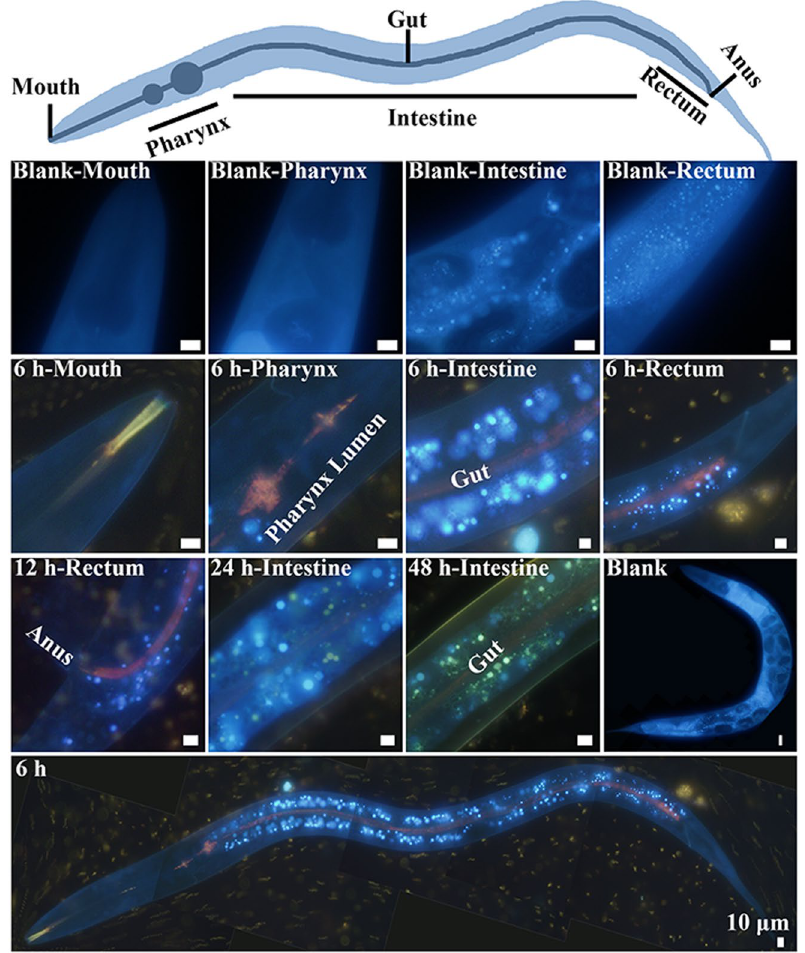
Figure 2. Distribution dynamics of CdSe QDs in C. elegans over time recorded using fluorescence microscopy. The blue signals represent the autofluorescence of C . elegans . The bright blue-green and light red fluorescence signals represent the dispersed and aggregated CdSe QDs, respectively. All the scale bars are 10 μ